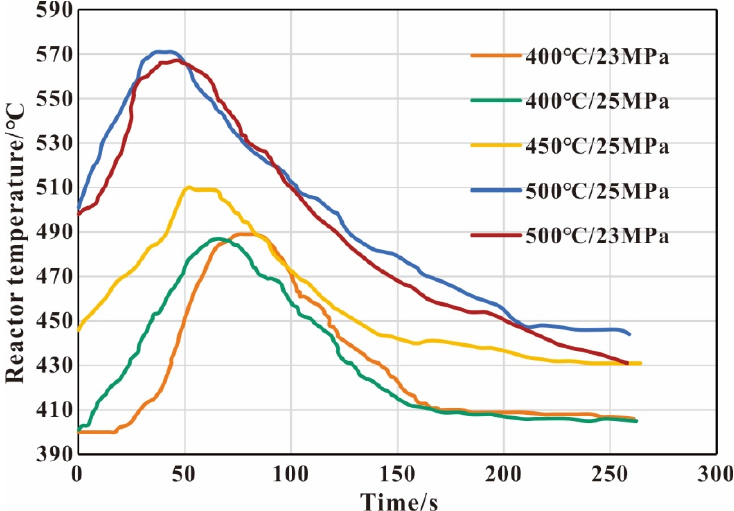
Figure 14. Temperature changes in the reactor during the experiment of supercritical water–crude oil reaction under different initial temperature and pressure conditions.